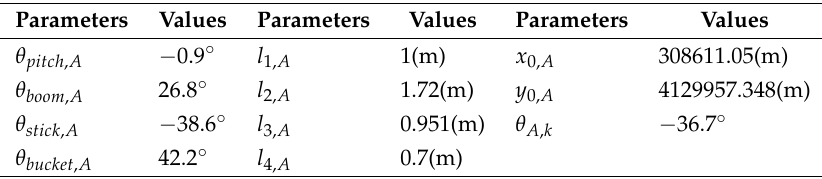
Table 5. Measured Posture Parameters: Same as Table 4.